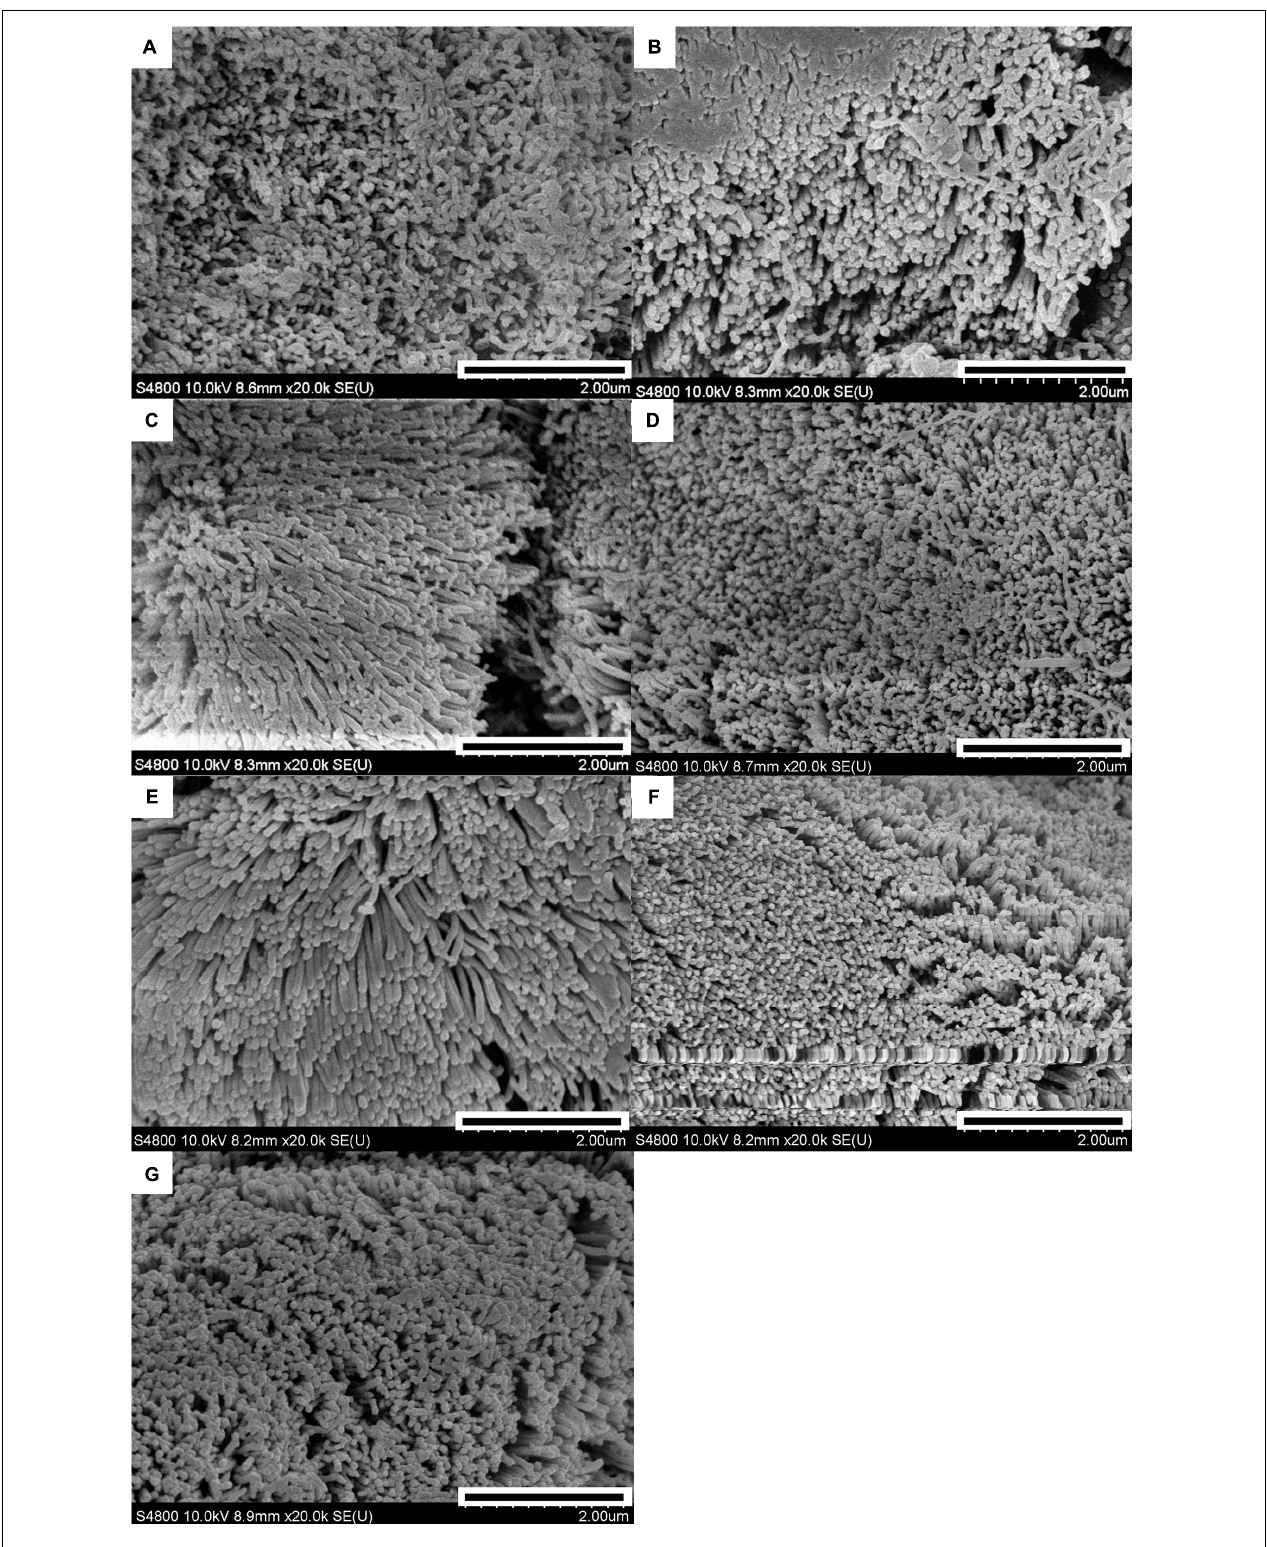
FIGURE 2 | Scanning electron microscopy of the small intestine of weaned piglets (20 k). (A–G) indicate the CON, ANT, ZO, NZO, LPNZ, MPNZ, and HPNZ groups, respectively. (A–G) show the villi magnified 20 k times under a scanning electron microscope. Each group of villi is densely covered with microvilli. The microvilli of CON are sparse compared to the other groups, and there is no significant difference in microvilli development among the other groups (A–G) .